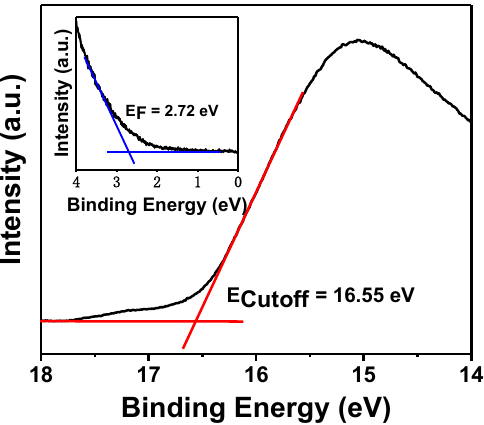
Figure 4. Ultraviolet photoelectron spectroscopy of Ag 3 PO 4 .